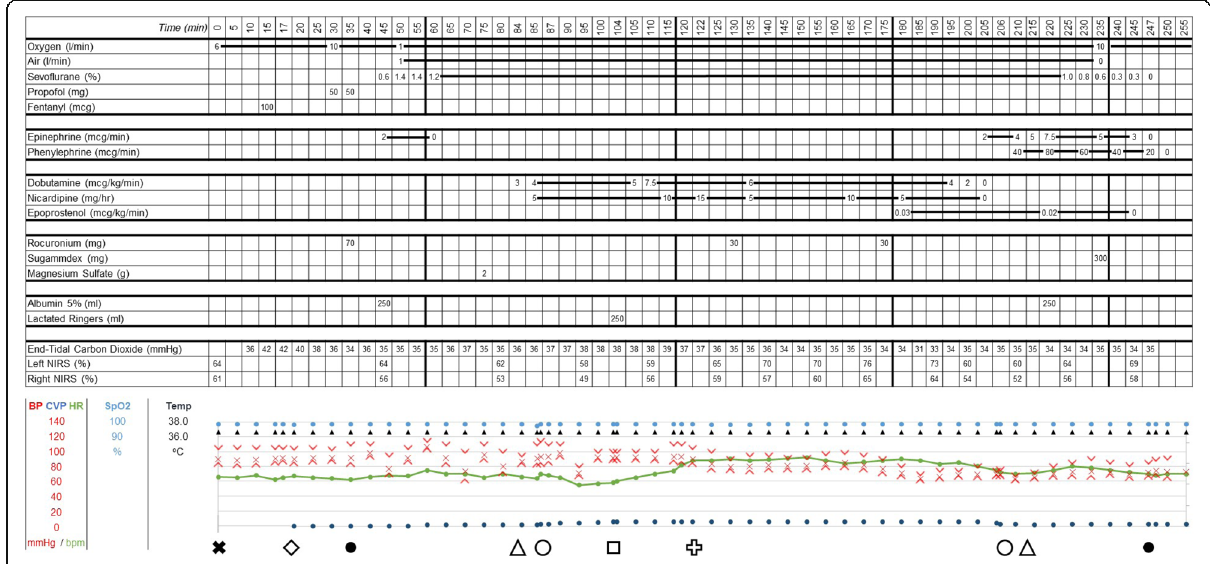
Fig. 1 Anesthetic record. black X, arterial line placement; white diamond, central line placement; black circle, tracheal intubation and extubation; white triangle, abdominal insufflation and desufflation; white circle into and out of steep Trendelenberg position; white square, aortic valve opening; white cross, transesophageal echocardiogram (TEE). BP, blood pressure; CVP, central venous pressure; HR, heart rate; SpO 2 , oxygen saturation percentage; Temp,